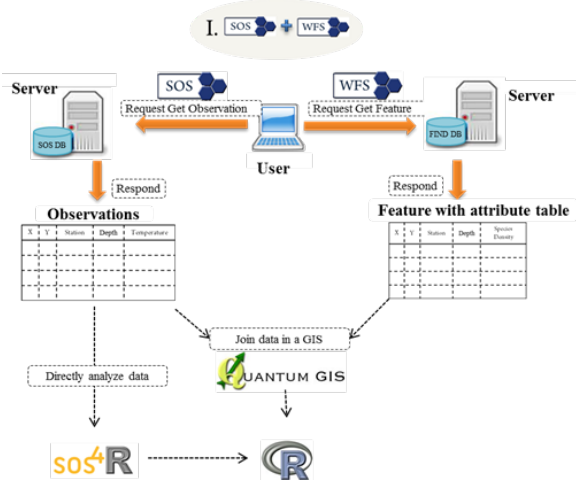
Table 2. Mapping solution between biological data and OGC SOS specification